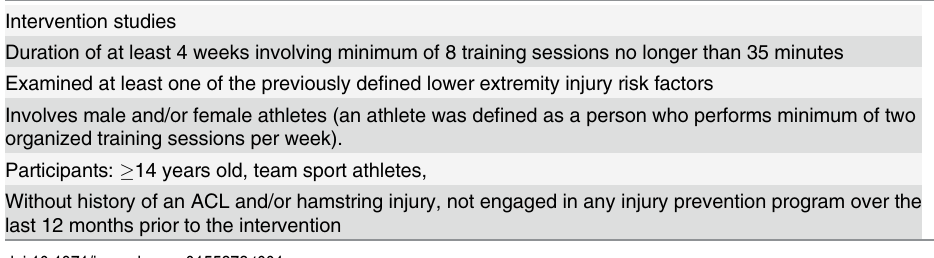
Table 1. Study Criteria for Inclusion in the